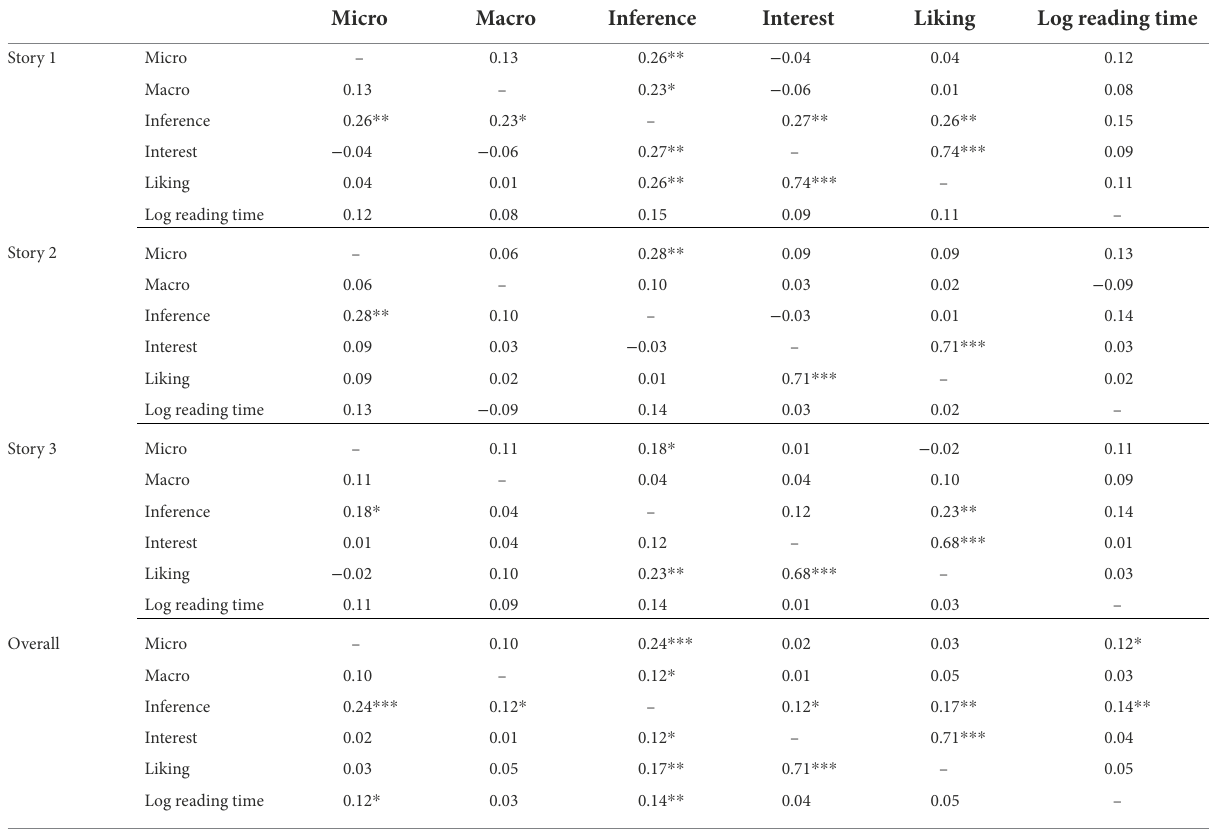
TABLE 4 Correlation matrix for wh-questions (selected